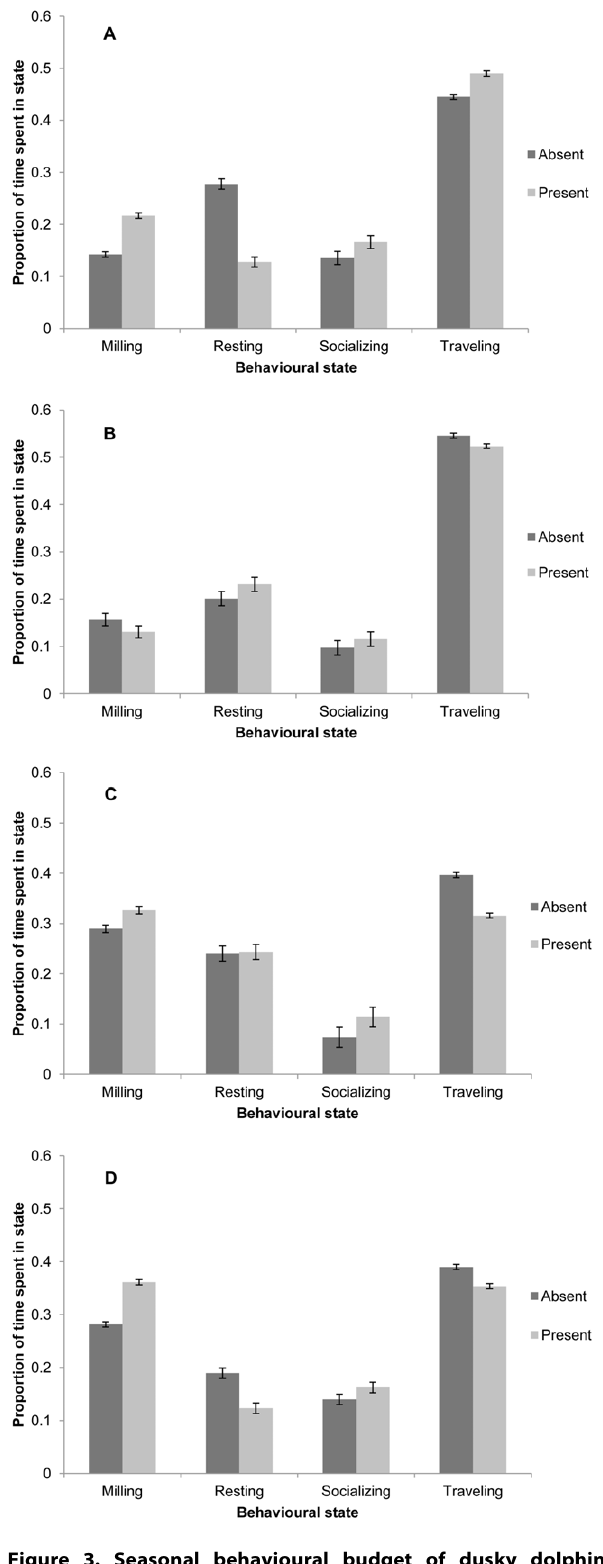
Figure 3. Seasonal behavioural budget of dusky dolphin groups in the presence and absence of vessels. Behavioural budget split by A) Summer, B) Autumn, C) Winter, and D) Spring. Error bars are 95% confidence